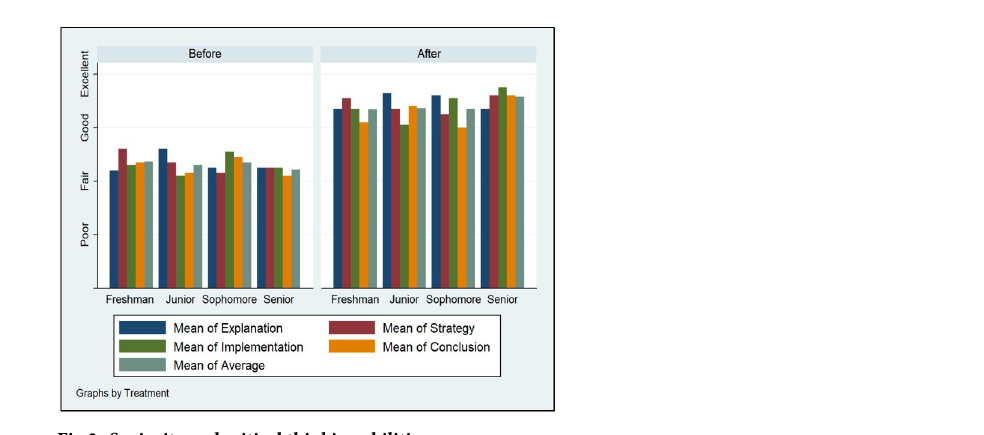
Fig 3. Seniority and critical thinking abilities.